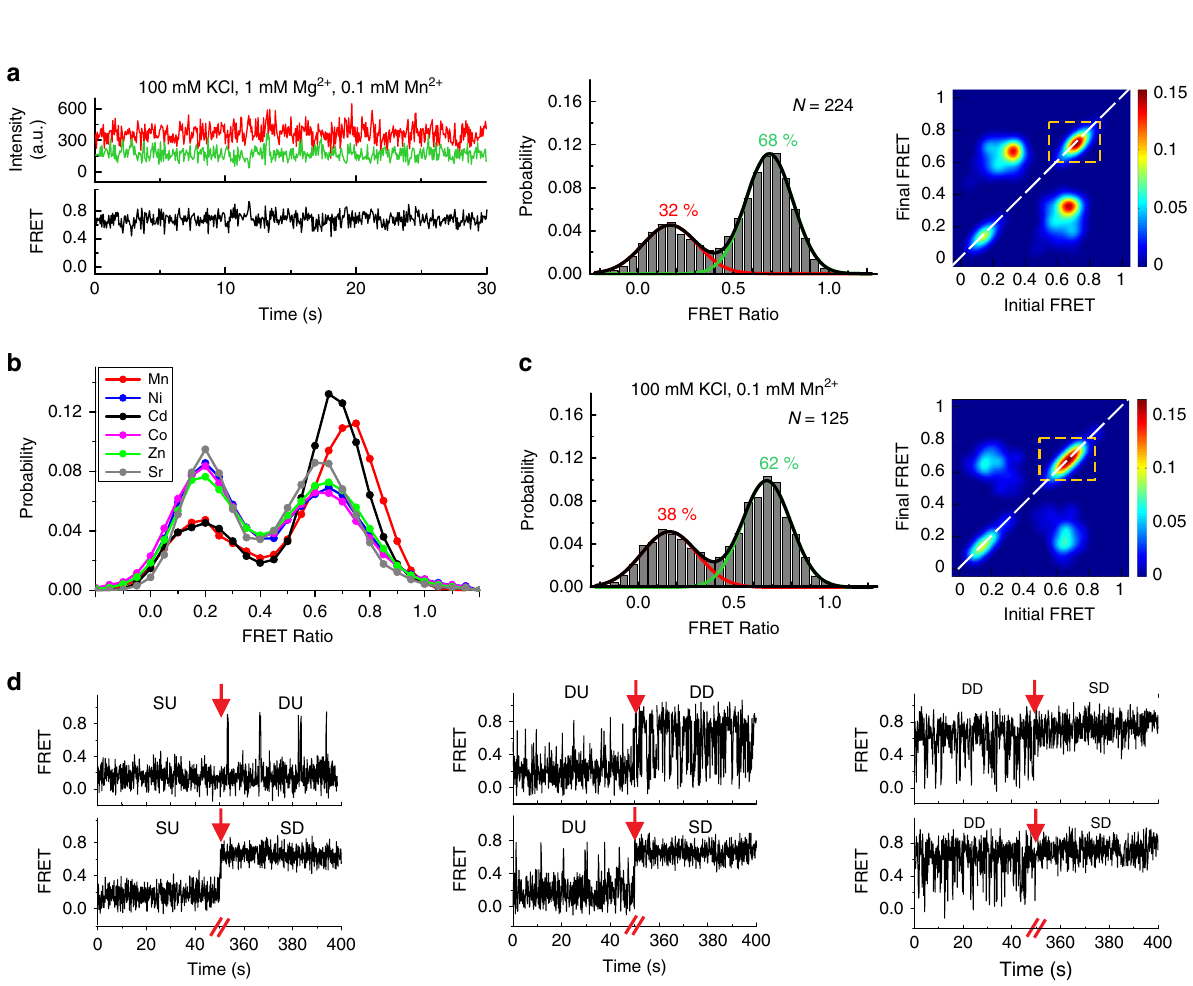
Fig. 5 Effect of Mn 2 + on the folding of the riboswitch. a Representative smFRET trace, FRET histogram and TODP for the WT riboswitch in the presence of 0.1 mM Mn 2 + and 1 mM Mg 2 + . The stable docked (SD) conformation appears only in the presence of Mn 2 + , as highlighted by the dashed yellow box in the TODP. b FRET histograms for the WT riboswitch at 0.1 mM concentration of different transition metals in the presence of 1 mM Mg 2 + . Over 150 molecules were analyzed for each histogram. The corresponding TODPs are shown in Supplementary Fig. 26. c FRET histogram and TODP with SD population highlighted by dashed yellow box for the WT riboswitch in the presence of 0.1 mM Mn 2 + alone. d Example smFRET traces for the WT riboswitch showing transitions between SU, DU, DD, and SD traces upon addition of 0.1 mM Mn 2 + . The time of Mn 2 + addition is indicated by the red arrow conformation, with the histogram showing a major single peak 0 : 88 s (cid:3) 1 (6%) (Supplementary Fig. 27). Importantly, the mutation around 0.19 ± 0.13 FRET, further corroborated by a single on- causes a striking loss of SD traces, as evident from the complete diagonal ~0.2 FRET contour in the TODP (Fig. 6d). These data absence of the on-diagonal ~0.7 FRET contour in the TODP demonstrate that the conserved discriminator A48 is essential for (Fig. 6c), in stark contrast to the WT. In addition, the mutant Mn 2 + inducing a SD riboswitch conformation. The presence of interestingly loses the WT ’ s ability to sample the docked Mg 2 + partially rescues the loss of Mn 2 + sensing by the mutant, conformations in the presence of 0.1 mM Mn 2 + alone (Fig. 6d); yet does not restore its ability to form the SD conformation. almost all smFRET traces at 0.1 mM Mn 2 + are in the SU NATURE COMMUNICATIONS| (2019) 10:4304